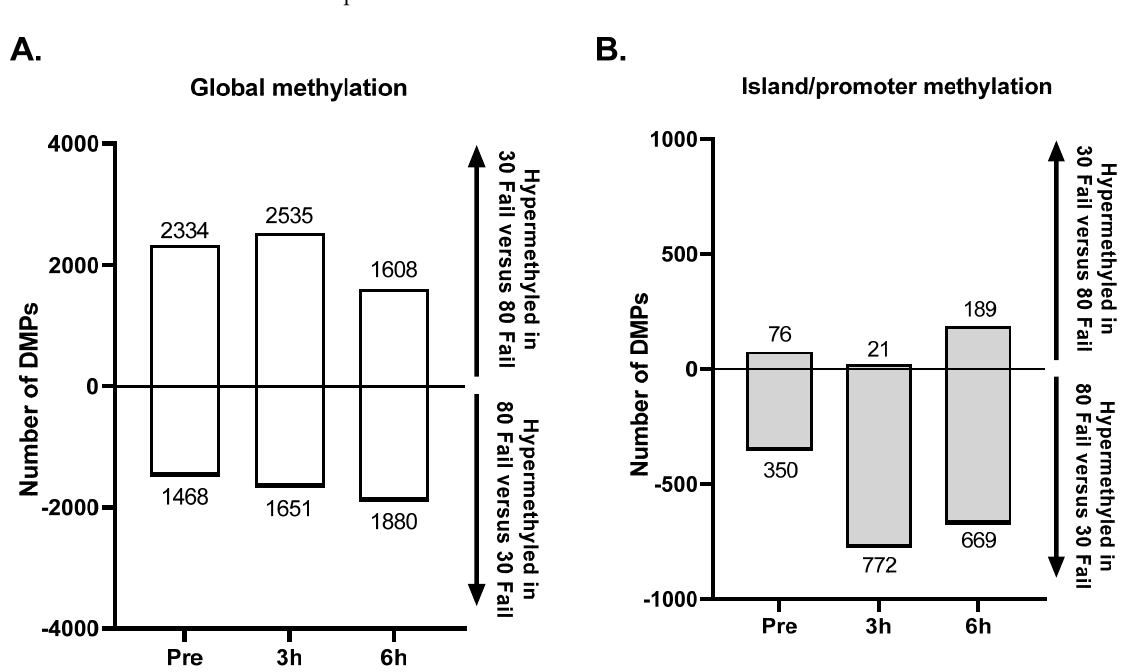
Figure 2. Volume and repetition differences between 30 Fail and 80 Fail bouts. Data are presented as mean ± SD for squat volume across sets and total squat volume (panel A ), leg extension volume across sets and total leg extension volume (panel B ), total volume for both exercises (panel C ), squat repetitions across sets and total squat repetitions (panel D ), leg extension repetitions across sets and total leg extension repetitions (panel E ), and total repetitions performed for both exercises (panel F ). Data are for n = 11 participants. Symbol: *, indicates significant difference between conditions per set and in totality ( p < 0.05). Abbreviations: 30 Fail, 30% one repetition maximum to failure bout; 80 Fail, 80% one repetition maximum to failure bout.